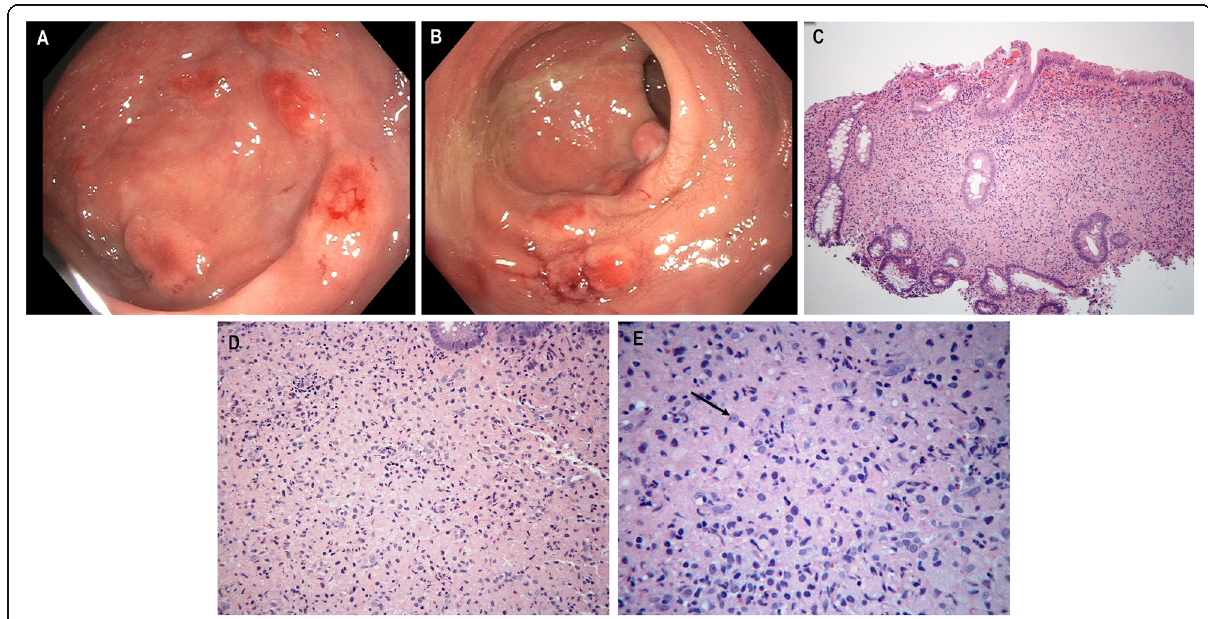
Fig. 1 Multiple circumscribed nodules are seen in the rectum on colonoscopy ( a ). There is also bleeding and erythema of the mucosa which led to hematochezia ( b ). There is marked expansion of the lamina propria by a predominantly histiocytic infiltrate. Colonic crypts are distorted and pushed aside. H&E 200x magnification ( c ). Histiocytes are filled with eosinophilic debris and have smooth nuclear contours with small, prominent nucleoli. Scattered heterogenous inflammation composed of neutrophils, lymphocytes and eosinophils is seen in the background. H&E 400x magnification ( d ). Higher power demonstrates Michaelis-Gutman bodies (arrow). These pale, targetoid and lamellated inclusions are seen in the cytoplasm of the histiocytes. H&E 600x magnification ( e